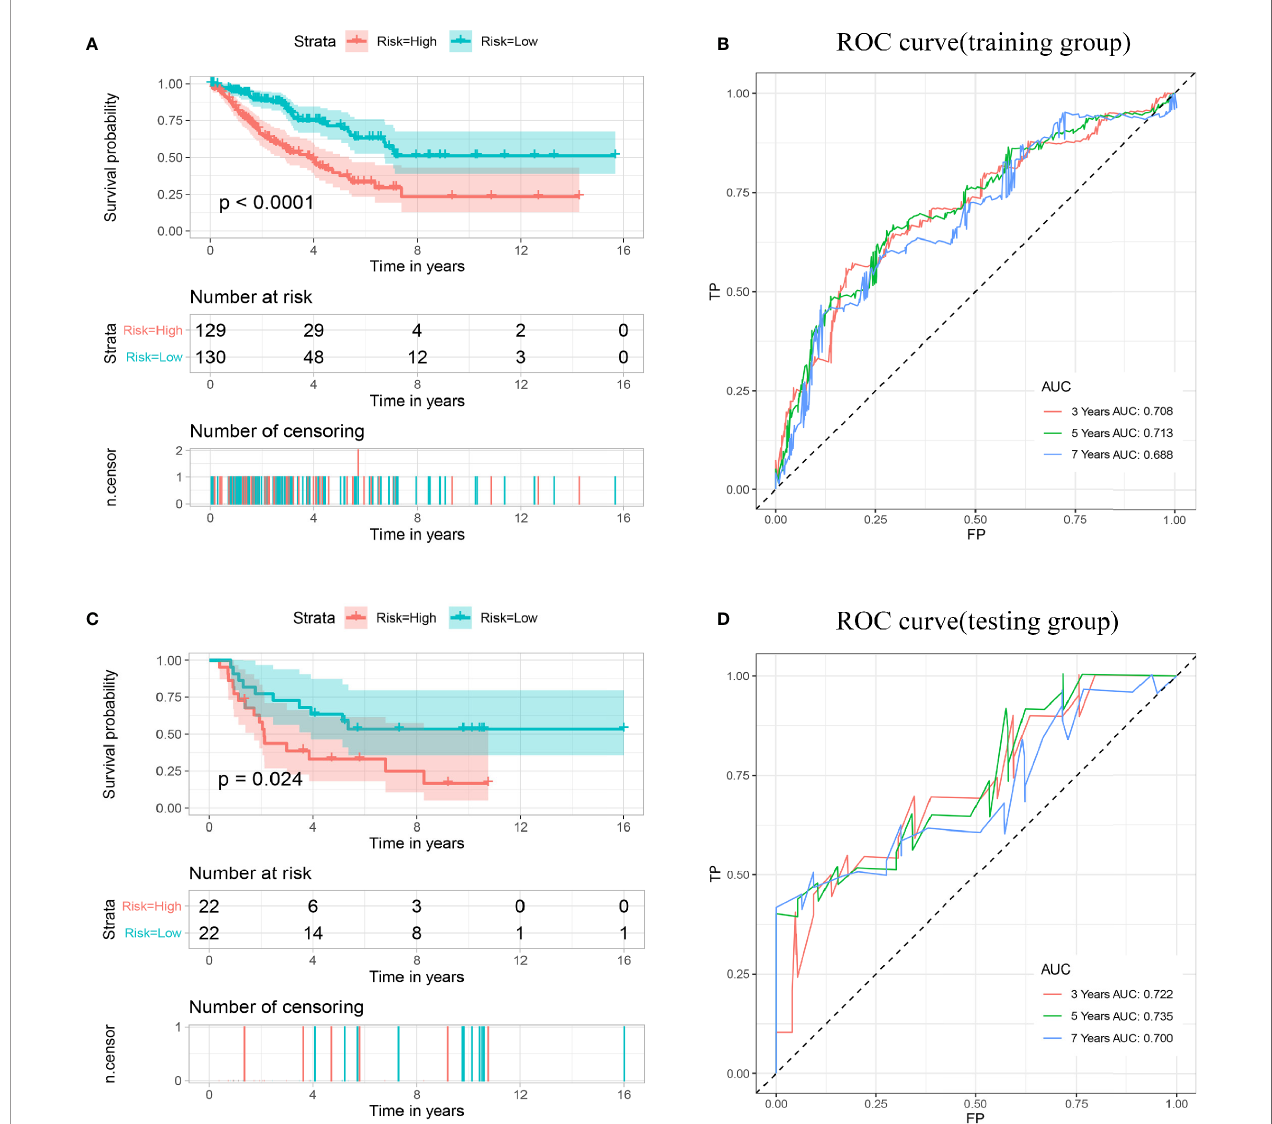
FIGURE 4 | Establishment and validation of a prognostic model related to OS based on IMGRs. (A) The survival curve shows that the OS status of high-risk and low-risk patients in the training cohort is different. (B) Receiver operating characteristic curve of the prognostic signature in the training cohort. (C) The survival curve shows that the OS status of high-risk and low-risk patients in the validation cohort is different. (D) Receiver operating characteristic curves of the prognostic signature in the validation cohort. OS, Overall survival; IMRGs, iron metabolism-related